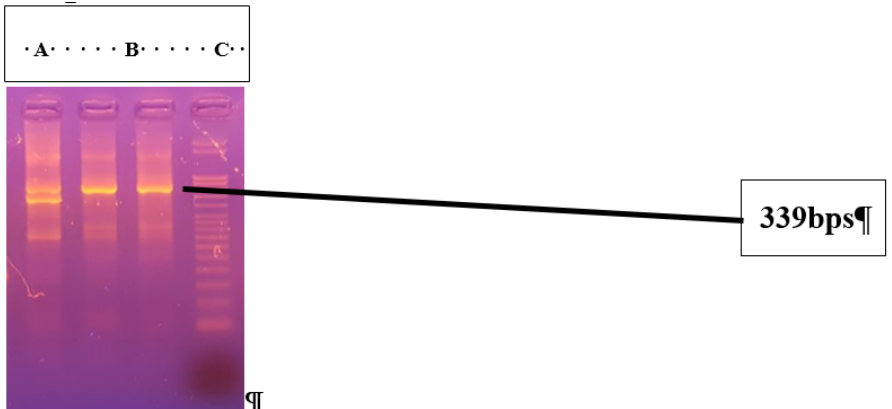
Figure 1. Ethidium bromide-stained agarose gel of the PCR products from genus-specific conventional PCR of Babesia infected dog blood samples. Lane L shows a DNA marker. Lanes from “A” to “C” are samples from naturally infected dogs showing a band of 339 bps .